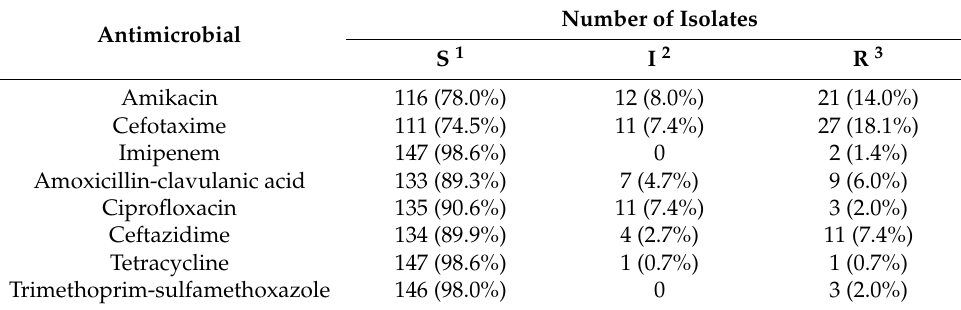
Table 1. Antimicrobial susceptibility of Vibrio spp. isolated over a one-year period. Antimicrobial